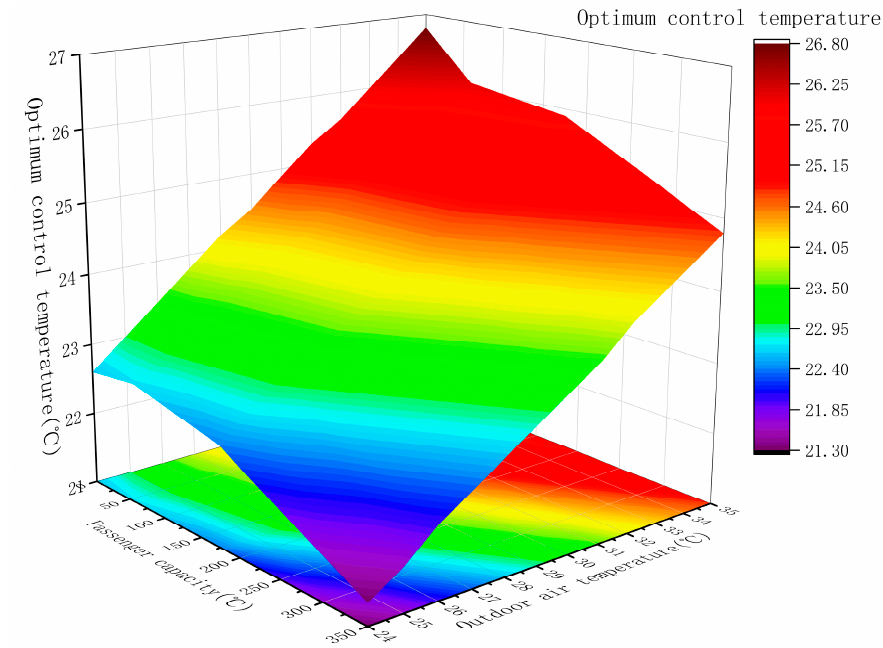
Figure 7. Control temperature as a function of passenger capacity and outside